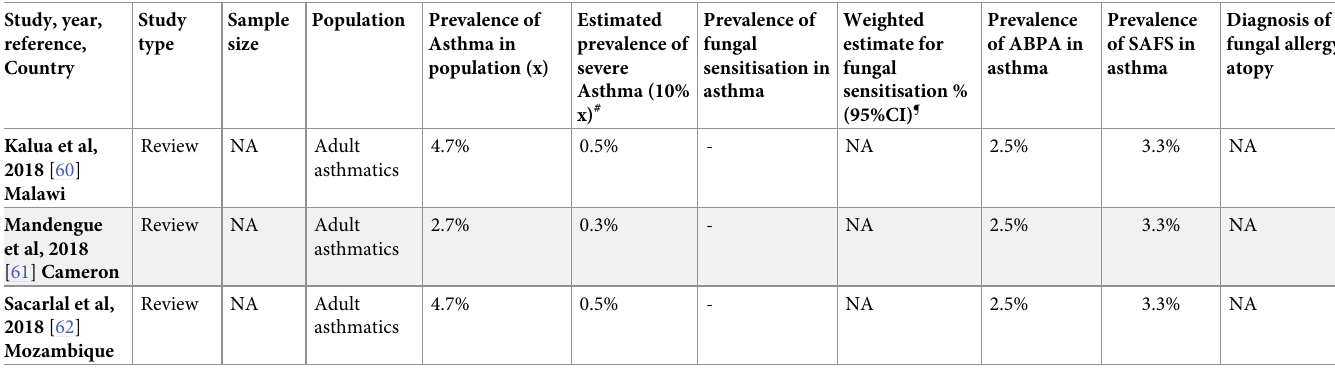
ranged from 2.9 to 51.9% with a pooled prevalence estimate of 23.3% (CI: 14.8 to 31.8, n = 8 studies). There was a lot of variation in the prevalence of fungal sensitisation across the eight cross-sectional studies included in the meta-analysis (heterogeneity test; p-value < 0.01) (Fig 4). The variation in the prevalence estimates attributable to heterogeneity was 98.1%. Only two studies [49,51] had very high variability in estimates; probably attributed to small sample sizes.